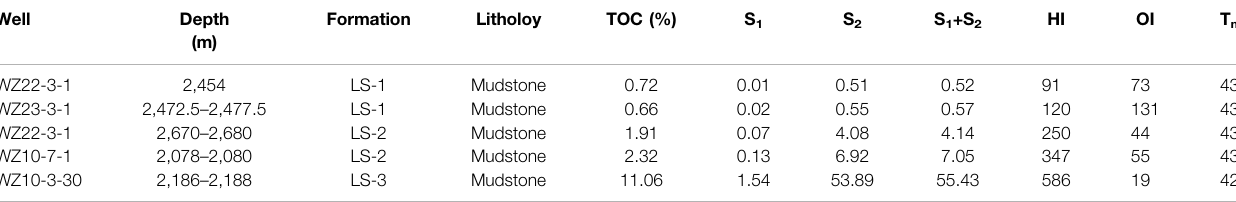
TABLE 1 | Rock-Eval data of core samples from the Liushagang Formation in the study area.